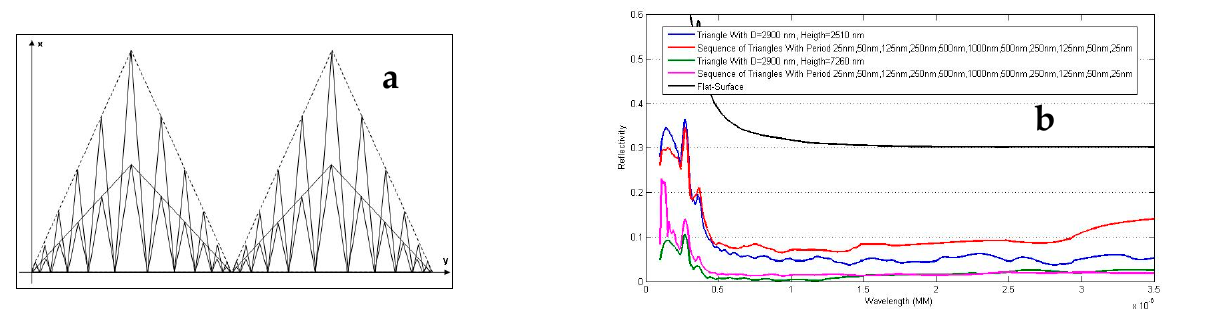
Figure 6. Spectral reflection of triangular surface rippling of triangular microstructures.